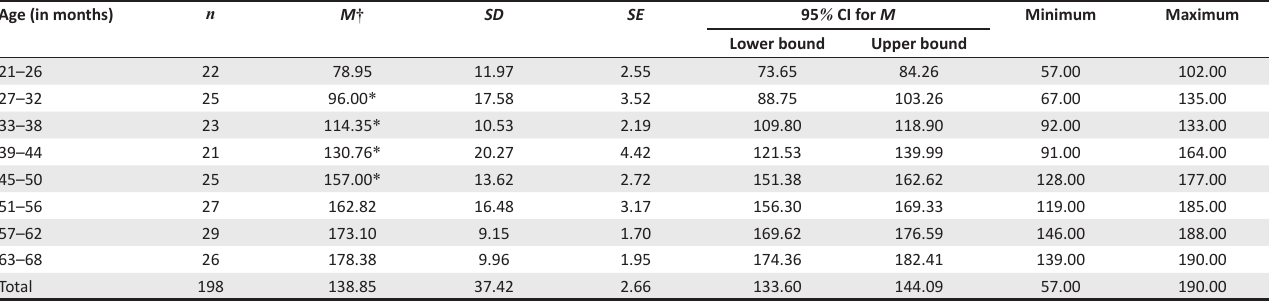
TABLE 5: Visual reception Mullen Scales of Early Learning raw scores, standard deviations, confidence intervals and the range of scores for each age group. Age (in months) n M SD SE 95 % CI for M Minimum Maximum 21–26